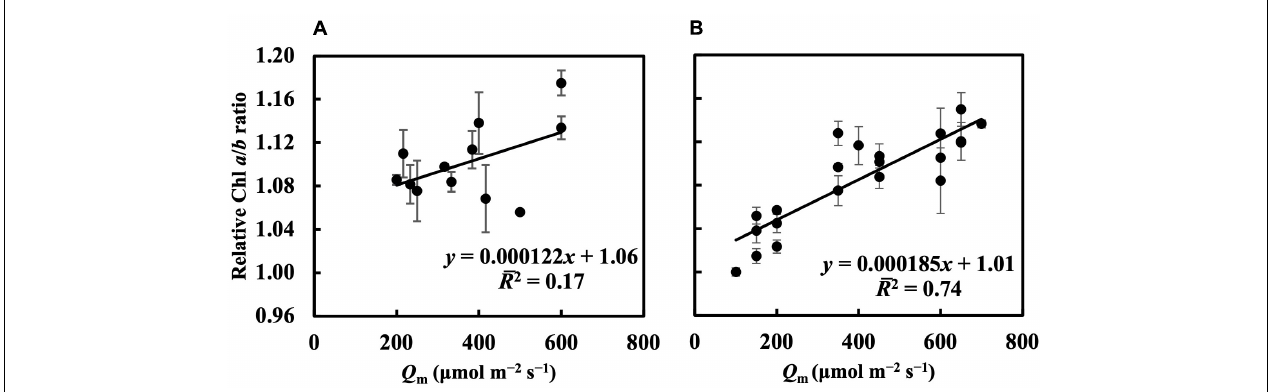
FIGURE 4 | Linear regression of relative Chl a / b ratio on Q m in the first (A) and second (B) experiment (see section “Treatments” for the details of treatment setting in each experiment). All values were means ± standard errors ( n = 3) and relativized to that for 100 µ mol m − 2 s − 1 . Regression lines, regression functions, and R 2 are shown.